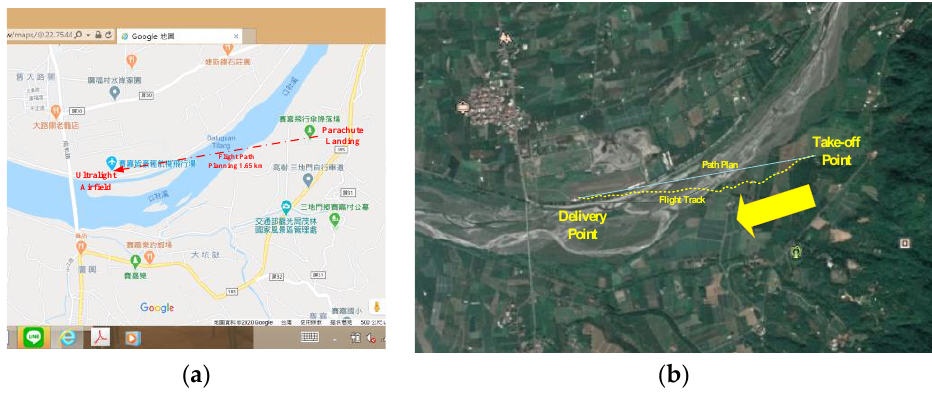
Figure 10. UAV delivery test 1 at Santiman across the river under 4G to UTM ( a ) Test 1 path planning; ( b ) Test 1 UTM tracking.